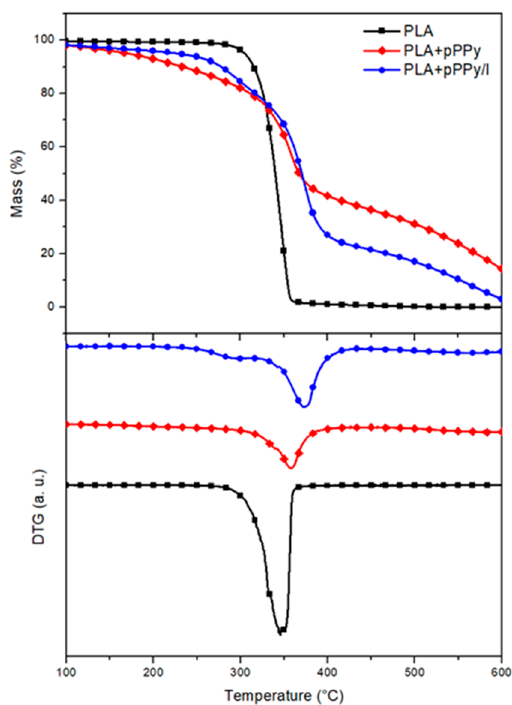
Figure 4. TG ‐ DTG plots of PLA, PLA+pPPy, and PLA+pPPy/I. Thermogravimetric plots ( top ) and derivative thermogravimetry plots (DTG, bottom ). derivative thermogravimetry plots (DTG, bottom